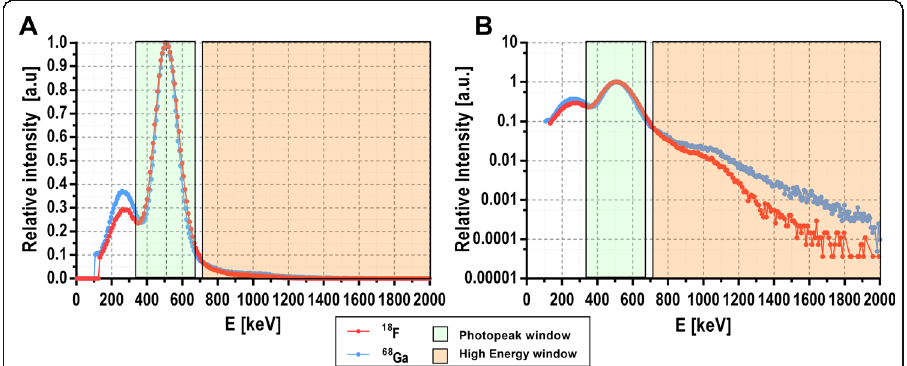
Fig. 2 Normalized energy spectra of single events recorded from 18 F (pure β + emitter, red) and the 68 Ga (non-pure β + emitter, blue) shown in linear ( a ) and logarithmic ( b ) scales. The green and orange boxes represent the energy windows set at (350, 700) and (750, 2000) keV to distinguish between photopeak (low energy) and high-energy events. The events recorded in the high-energy window are relatively higher for 68 Ga than for 18 F compared with the event recorded in the